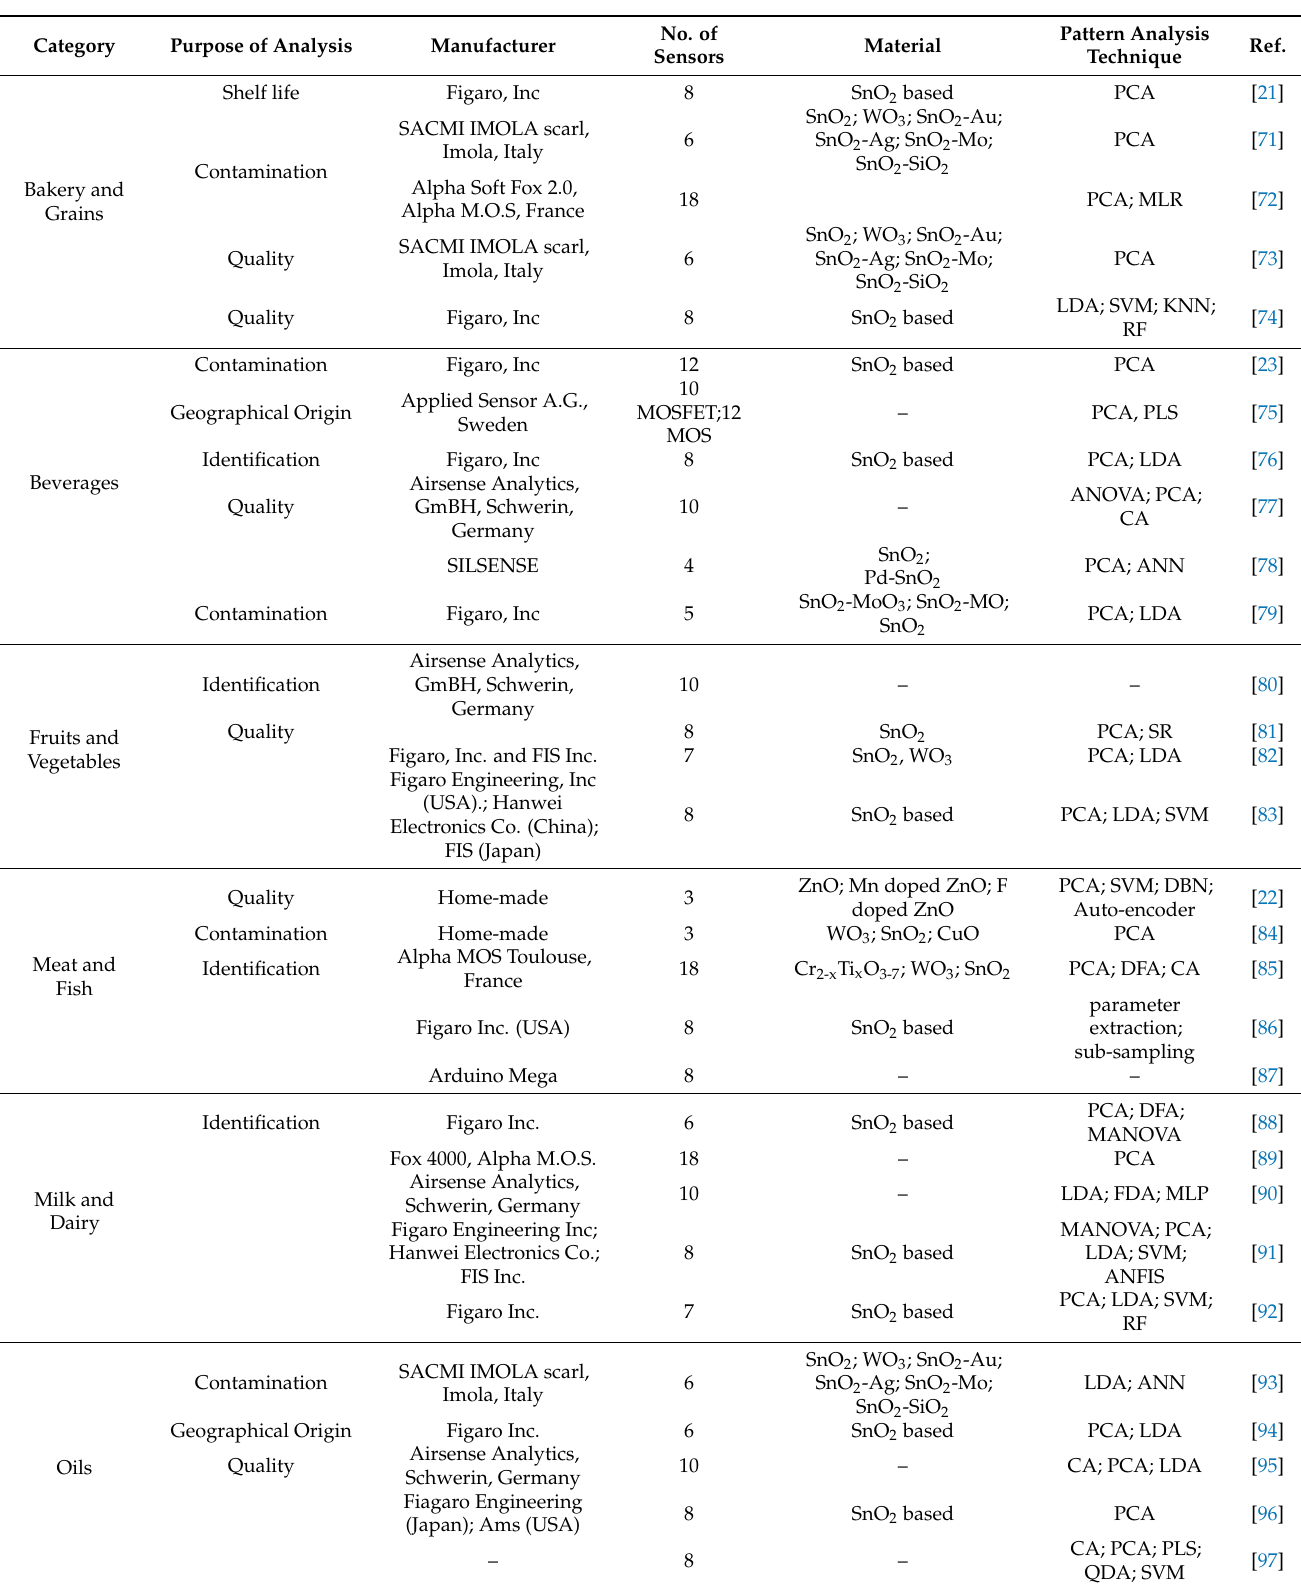
Table 1. Overview of various Enoses used in food industry